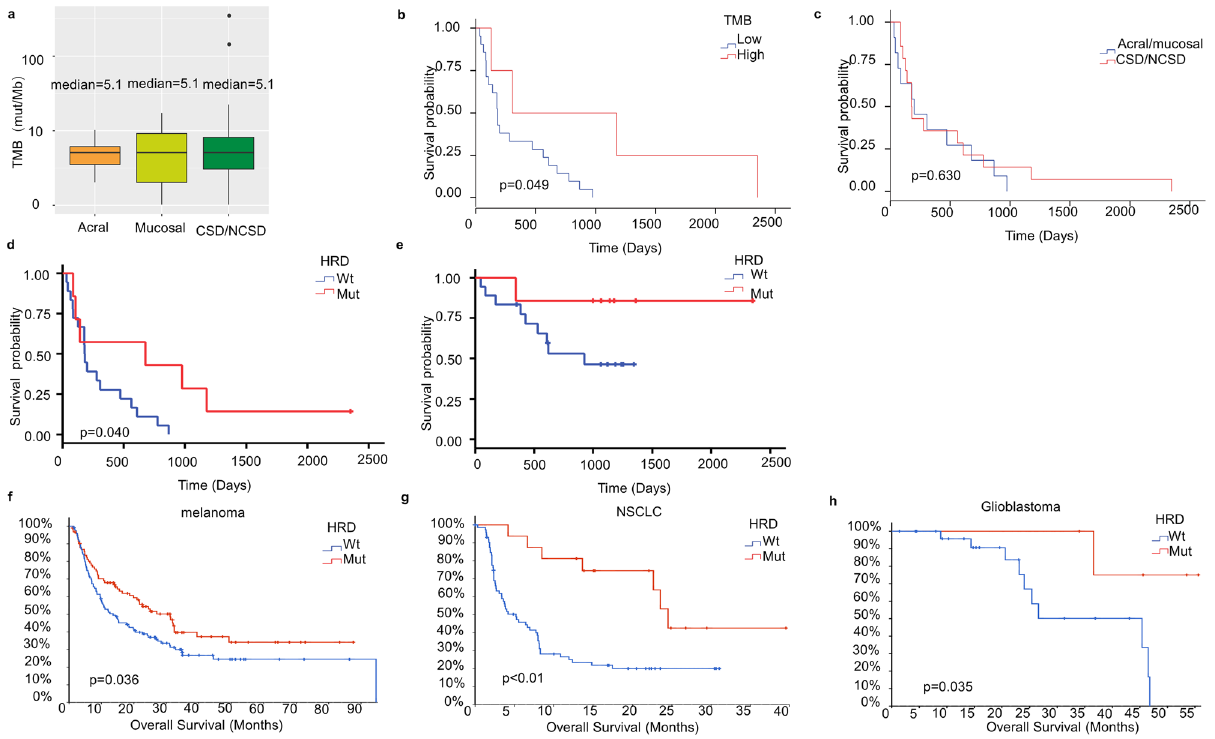
Figure 4. Comparison of TMB in three subtypes and genes related to immunotherapy effect. ( a ), TMB in cutaneous, mucosal and acral melanoma (p = 0.692, Mann–Whitney test). ( b – g ), Kaplan Meier assessments of progression-free survival (PFS) in patients treated with immunotherapy in our cohort (n = 25) according to the following classes: b, high TMB (> 15 mut/Mb) and low TMB (≤ 15 mut/Mb); ( c ) cutaneous group with acral/mucosal group; ( d ) PFS of HRD wt and HRD mut; ( e ) OS of HRD wt and HRD mut (HRD related genes: CHEK1, CHEK2, BRCA1, BRCA2, ATM, PALB2, BAP1, IDH1 ); f–h, Association of HRD mut with patient survival of melanoma (UCLA, Cell 2016 + MSKCC, NEJM 2014 + DFCI, Science 2015, n = 202) 15–17 , NSCLC (MSK, Cancer Cell 2018, n = 75) 18 and glioblastoma (Columbia, Nat Med. 2019, n = 42) 19 after immunotherapy in cBioPortal